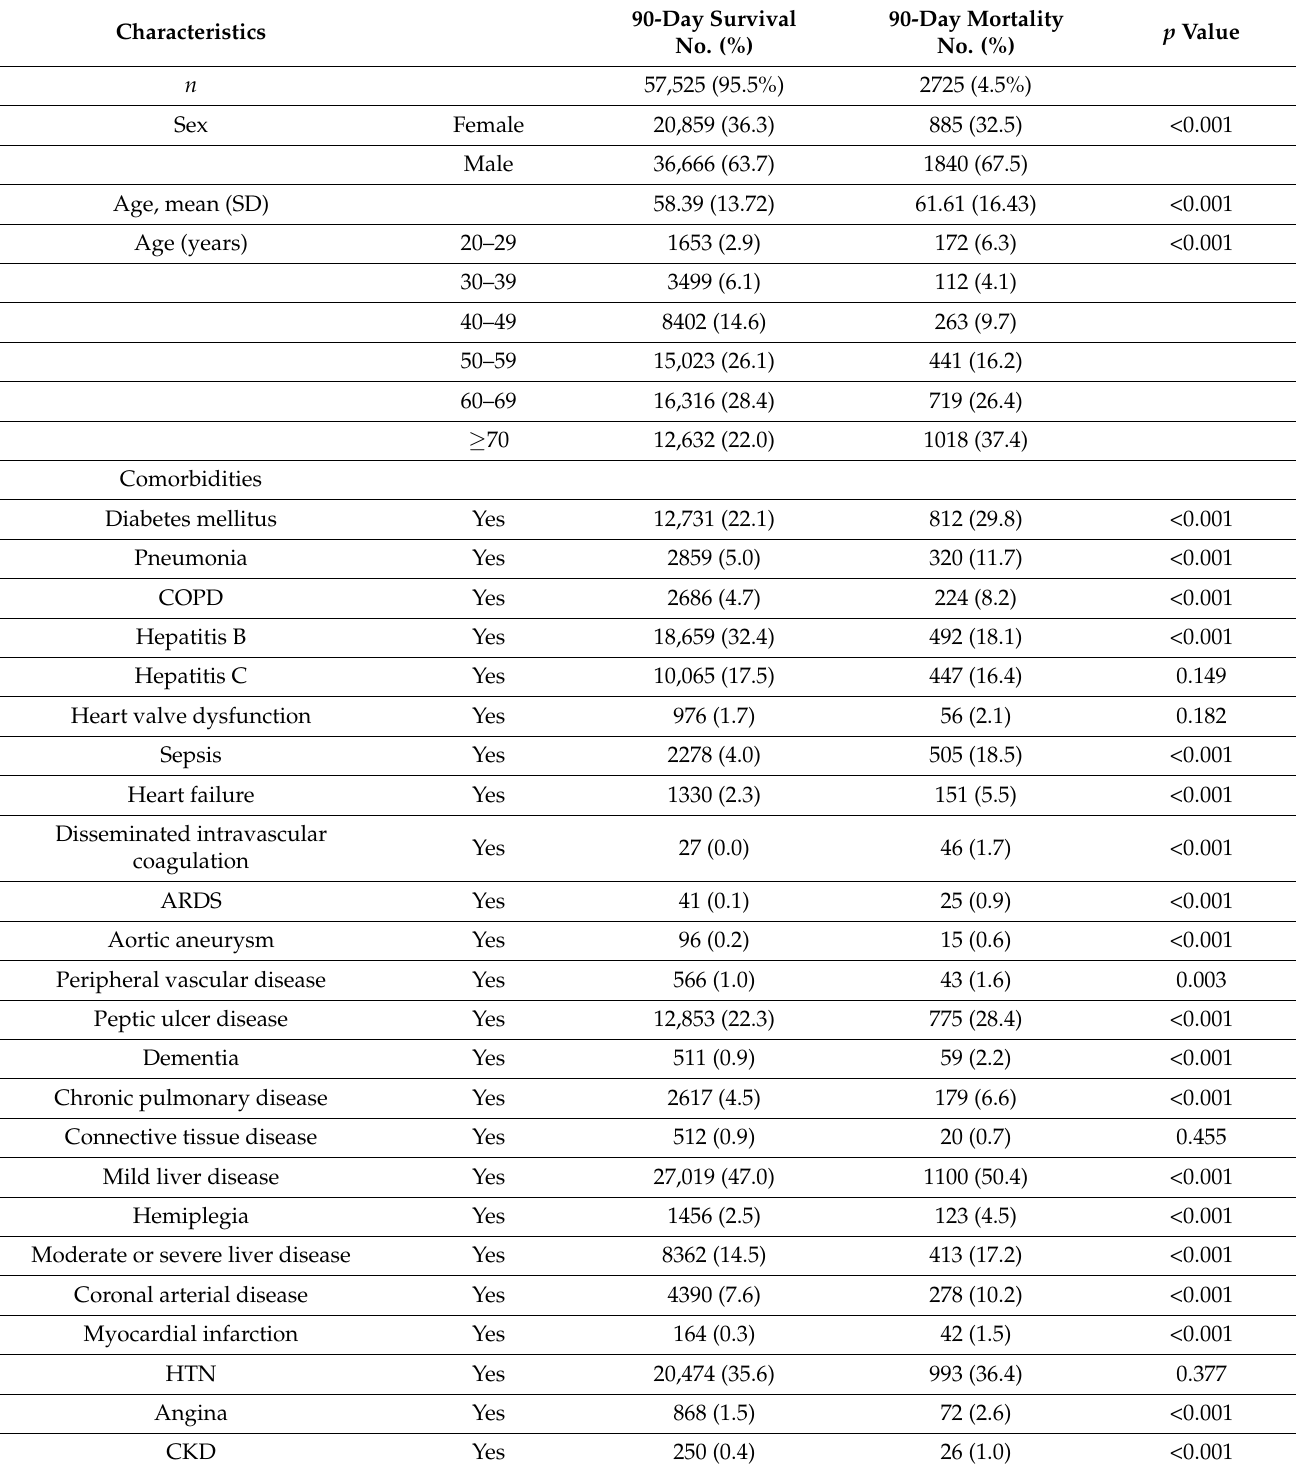
Table 1. Demographic Characteristics of the 90-Day Mortality and 90-Day Survival Groups of Patients with Hepatocellular Carcinoma Undergoing Major